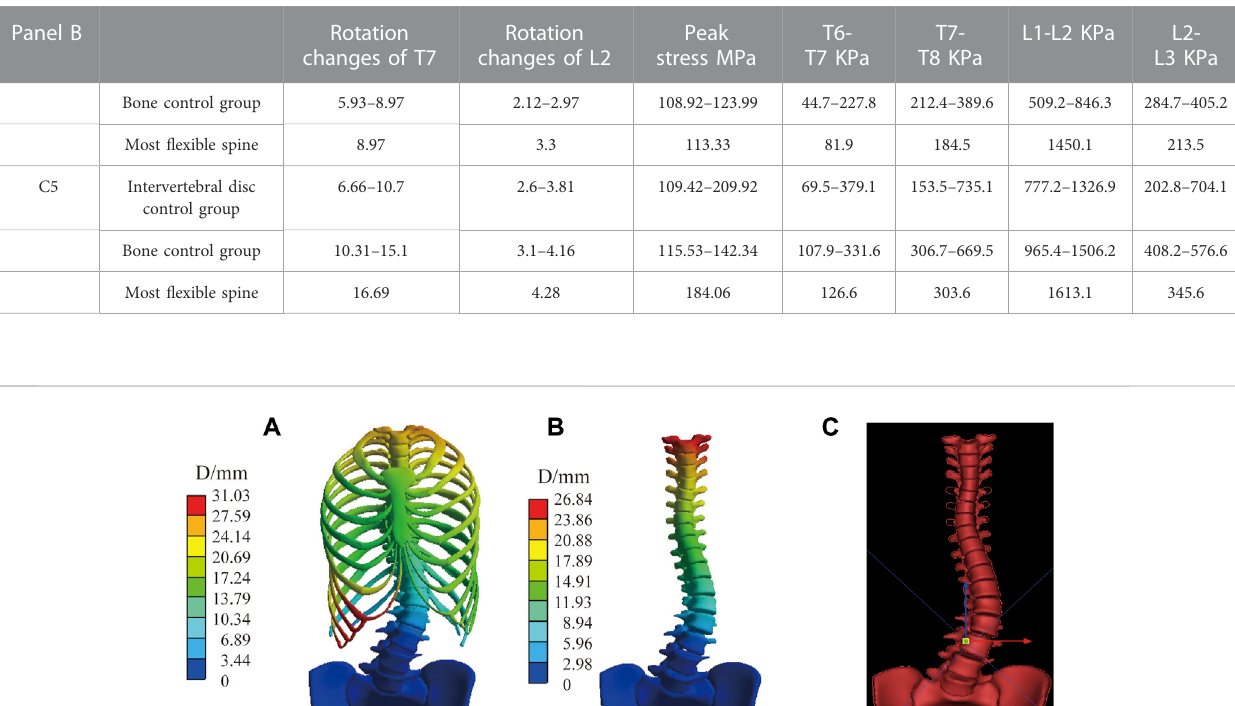
of bone elastic modulus. The bone and intervertebral disc both signi fi cantly in fl uence the axial rotation of the vertebral body. Figure 10 shows that the stress distribution under fi ve force con fi gurations in normal spine. The stress of cortical bone was greater than that of cancellous bone. The peak stress occurred at the junction of T6 and sixth rib on the convex side of cruve under C1,